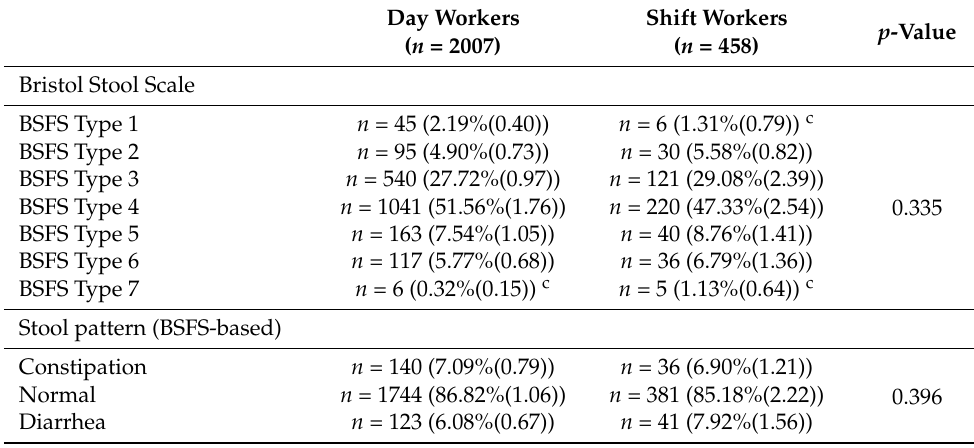
Table 3. Bowel health characteristics: a comparison by shiftwork